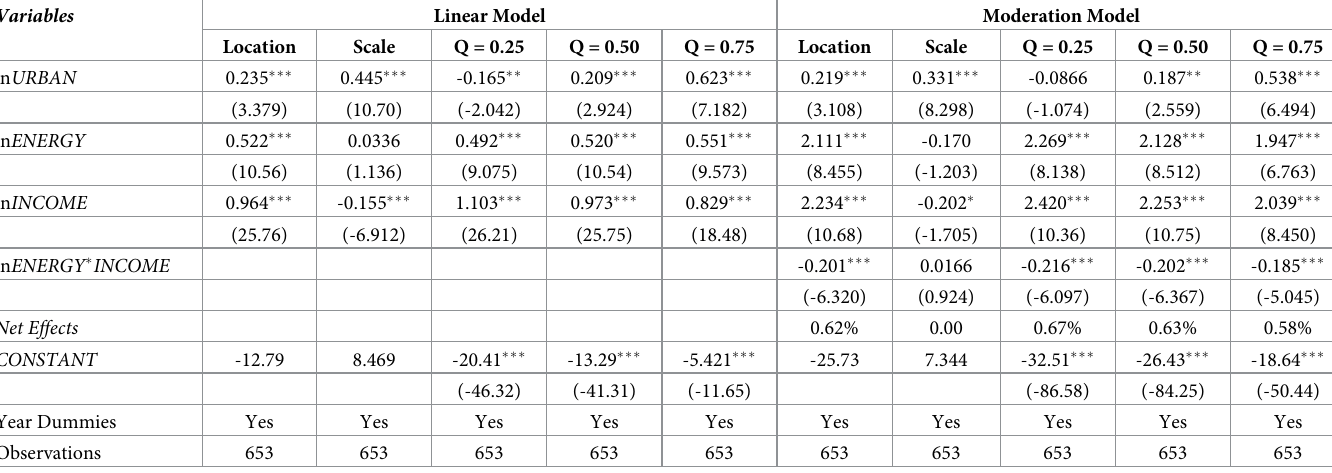
Table 6. Distributional Effects from MM-QR Technique, Full Sample (Dep. Variable: lnEMS).